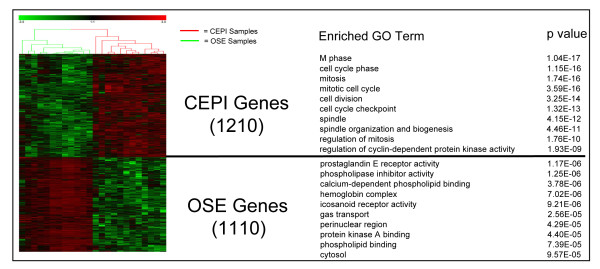
Hierarchical clustering and gene ontology (GO) enrichment of 2320 genes differentially expressed between ovarian surface epithelial cells and ovarian cancer epithelial tissue. The heat map (left) was generated by Z-score normalization of log2 expression values from Affymetrix HGU133 Plus 2.0 3. Displayed are the relative expression levels of genes (rows) differentially expressed (red = relatively over-expressed; green = relatively under-expressed) in 12 ovarian surface epithelial brushings and 12 laser capture microdissected malignant epithelia samples (columns). Unique, enriched GO terms are listed for each set of differentially expressed genes and their statistical significance by false discovery rate (FDR) corrected, hypergeometric distribution p-values. Genes overexpressed in CEPI are labeled as CEPI Genes overexpressed in OSE are labeled OSE Genes.